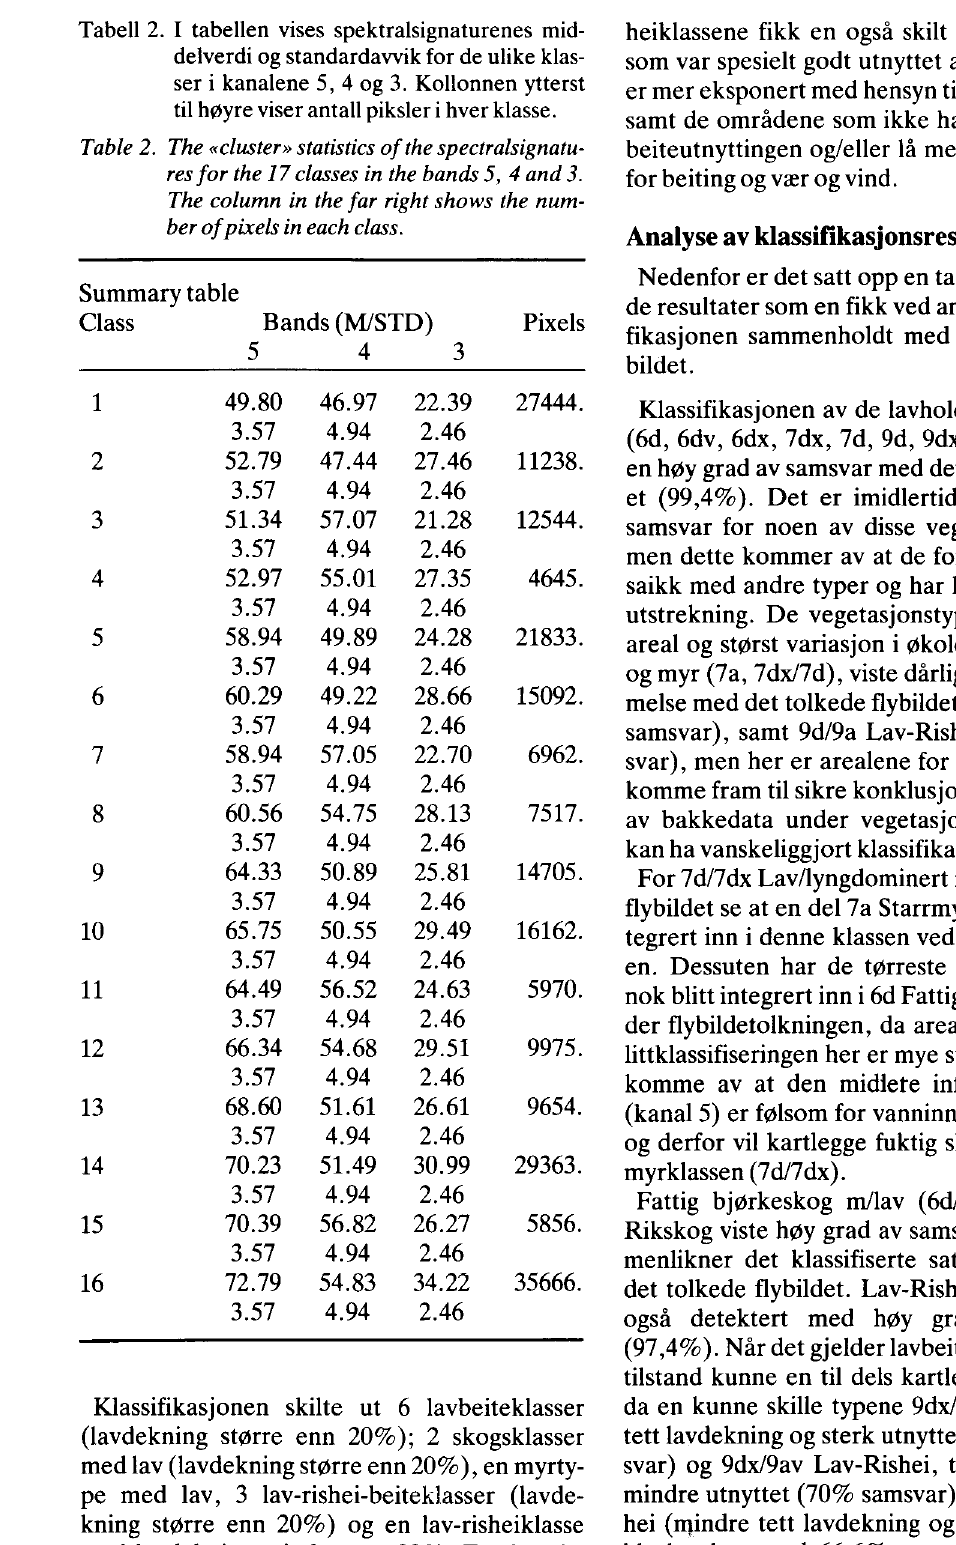
heiklassene fikk en også skilt ut de områdene som var spesielt godt utnyttet av reinen og som er mer eksponert med hensyn til vind og erosjon samt de områdene som ikke hadde den samme for beiting og vær og